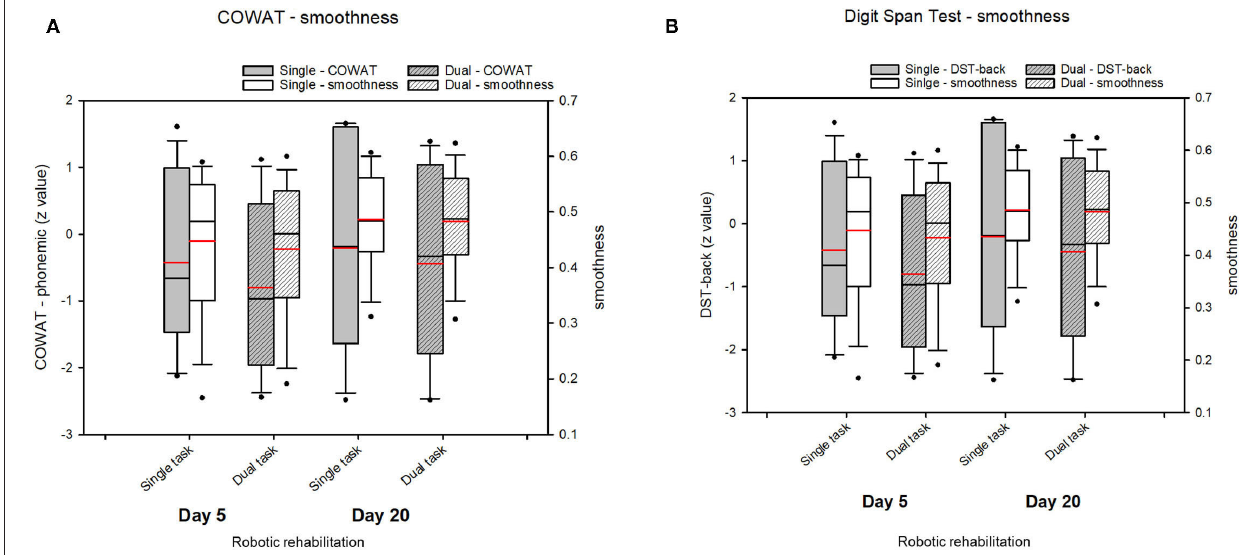
FIGURE 2 | Change of the dual-task effect (DTE) value after robotic rehabilitation of the upper limbs. (A) COWAT_phonemic and smoothness, (B) Digit Span Test and smoothness. The change in the DTE of cognitive or motor performance between day 5 and day 20 during the dual task did not indicate significant changes in the DTE on motor, cognitive, or the sum of motor and cognitive performance. Boxplots represent the mean of z -value for each group over the course of robotic rehabilitation. Boxplots display lower and upper extremes, lower and upper quartiles, and medians. Red line in boxplots indicates the mean. The black whiskers mark the 5th and 95th